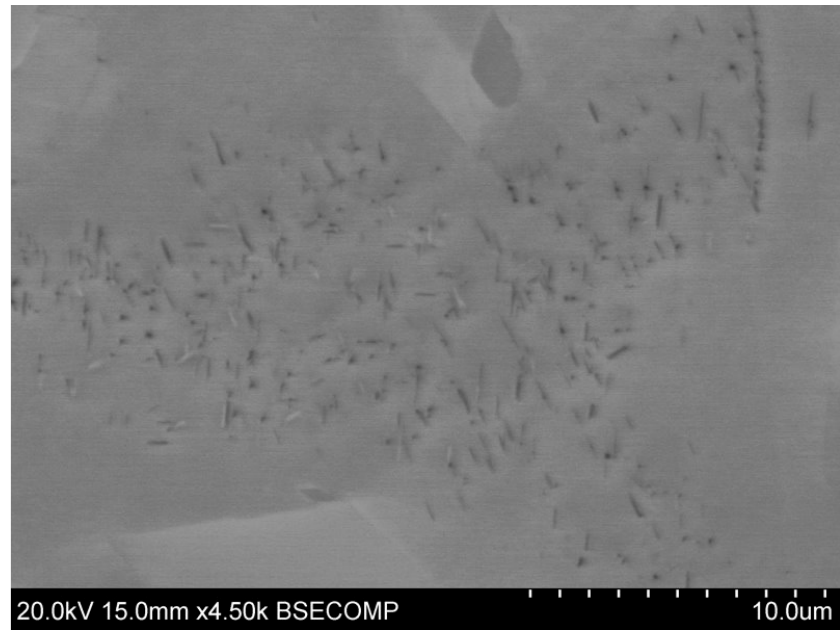
Figure 17. SEM image of Cr nitrides in HAZ of building plate.